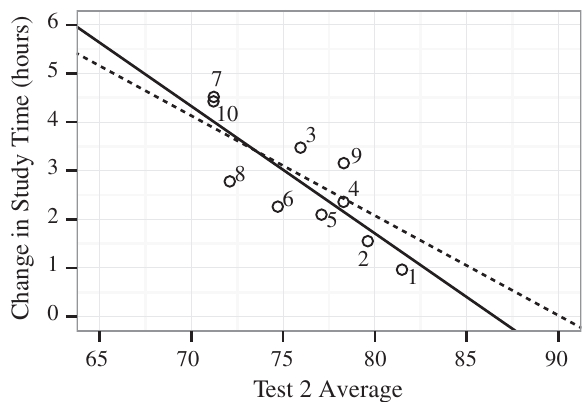
FIG. 3. Change in exam study time vs test 2 average by academic year. The solid line is the regression line using all 10 academic years; the dashed line eliminates semesters 1 and 2 to investigate the influence of these